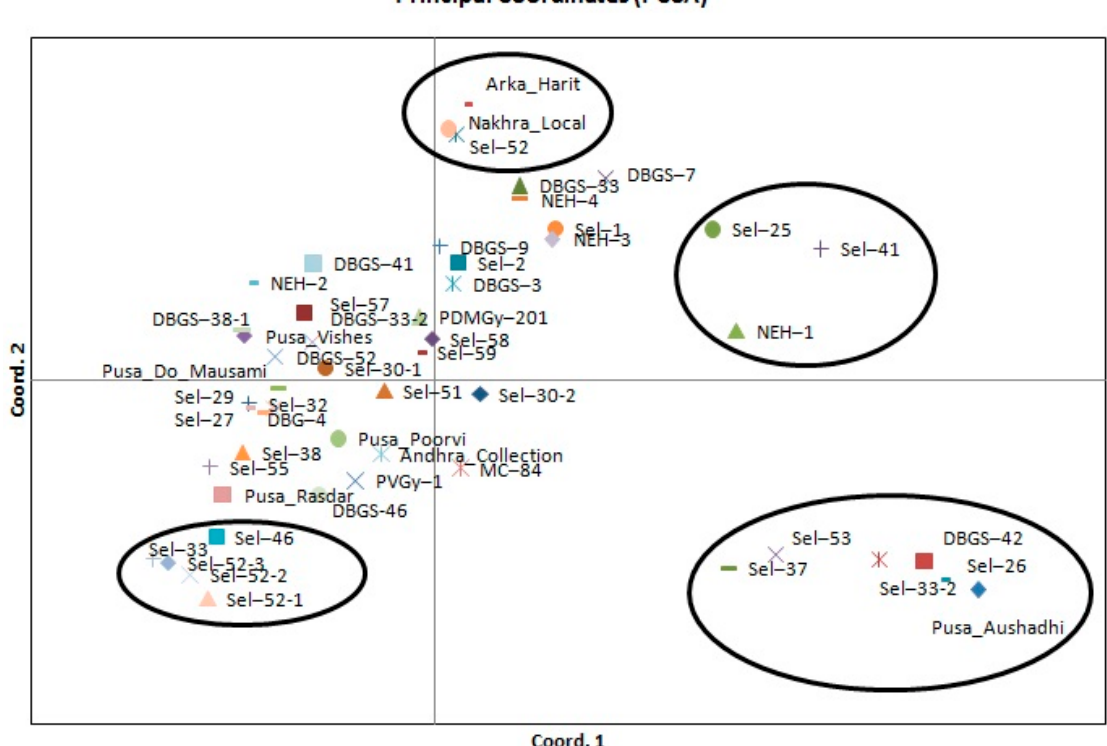
Figure 4. Principal coordinate analysis (PCoA); variation on axis 1: 13.48%, axis 2: 7.23%, axis 3: 6.76% and total variation 27.47%.